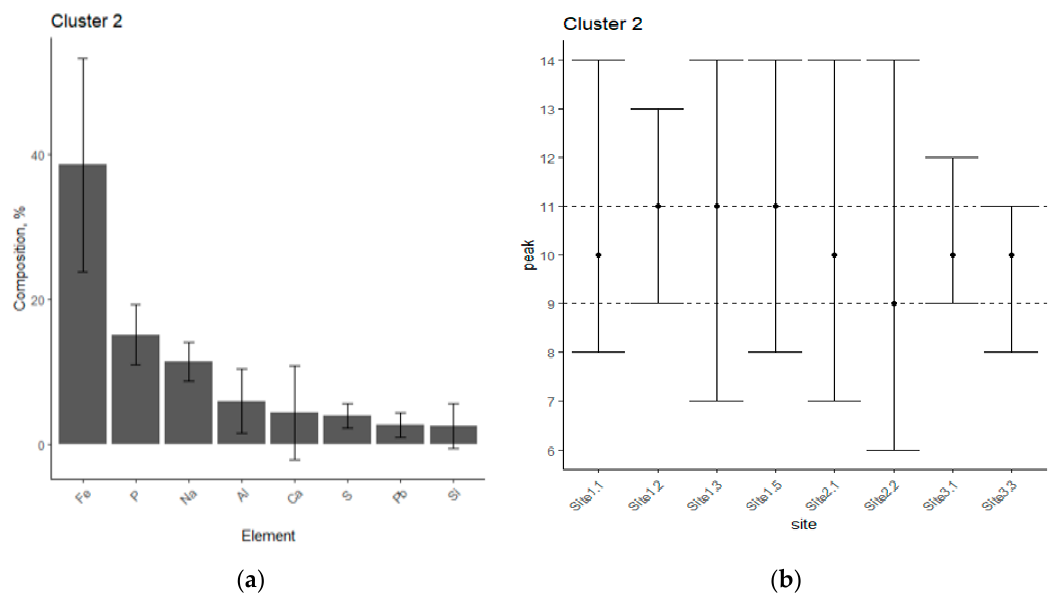
Figure 5. ( a ) Average chemical composition and standard deviation of the components in cluster 2; ( b ) extraction peak location and their windows of extraction for cluster 2 components. ( b ) extraction peak location and their windows of extraction for cluster 2